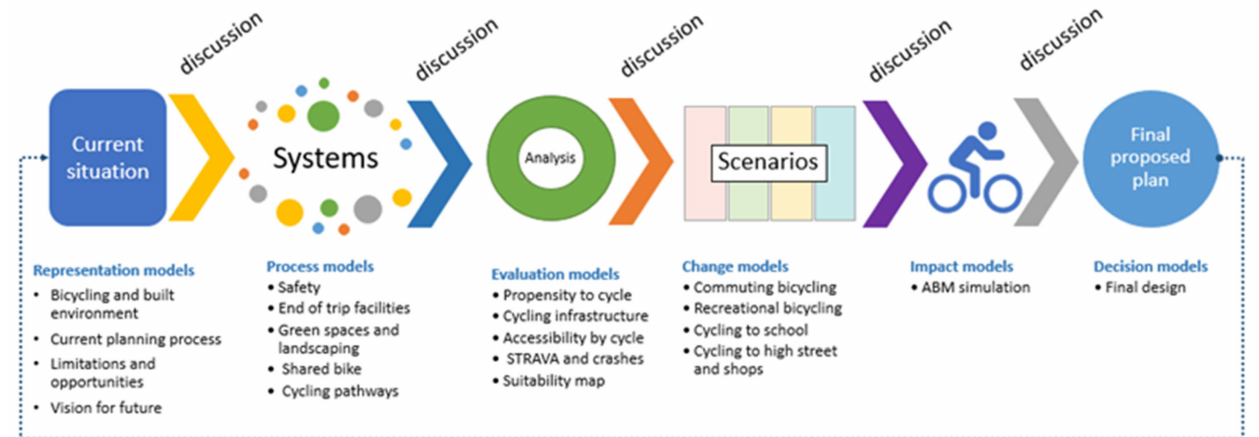
Figure 1. Workflow of the geo-design workshop adopted from